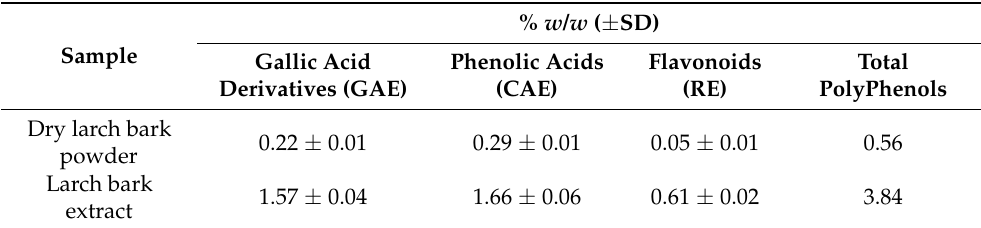
Figure 5. HPLC-MS chromatograms showing the distribution of type -B procyanidins in dry larch bark powder (panel A ) and larch bark extract (panel B ). Table 2. Relative PAC-A and PAC-B % and PAC-A/PAC-B ratio related to polymerization degree Table 3. Quantitative characterization of phenolic profile in dry larch bark powder and of PACs contained in dry larch bark powder and in larch bark extract. Data were obtained by